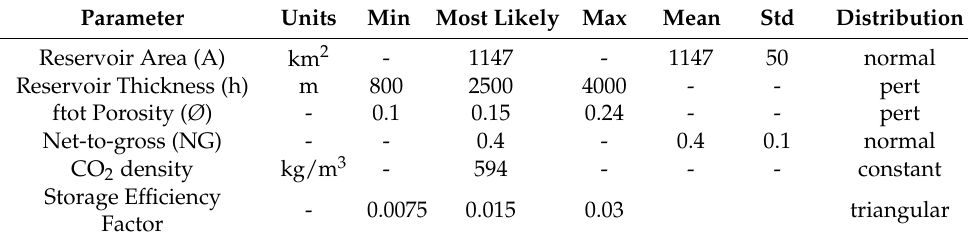
Table 7. Parameter distribution for the Pentalofos Formation.